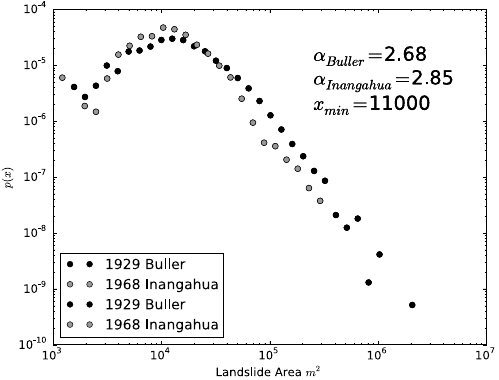
Figure 8. Probability densities of landslide areas as a function of landslide area for the 1929 Buller and 1968 Inangahua earth- quake landslide inventories. Power-law scaling exponents( α ) have been derived using the method of Clauset et al. (2009), for areas >11000m 2